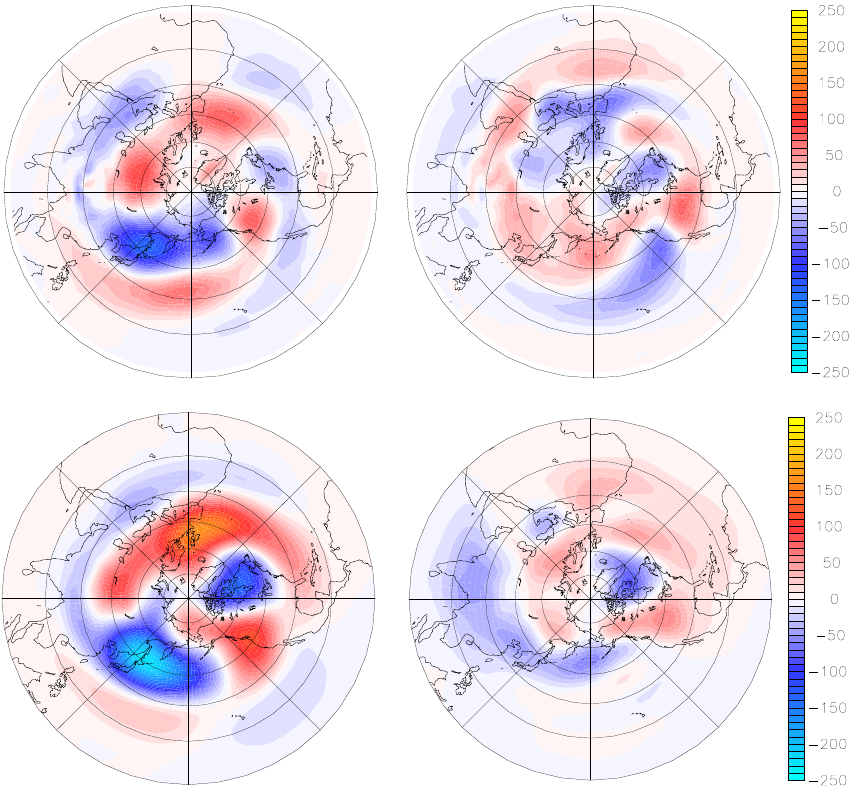
Fig. 5. The zonal eddy component of the geopotential height at 500 hPa in m in DJF (left) and JJA (right) of the mean of the SPEEDO ensemble (top) and the reanalysis data from Kalnay et al. (1996), (bottom).